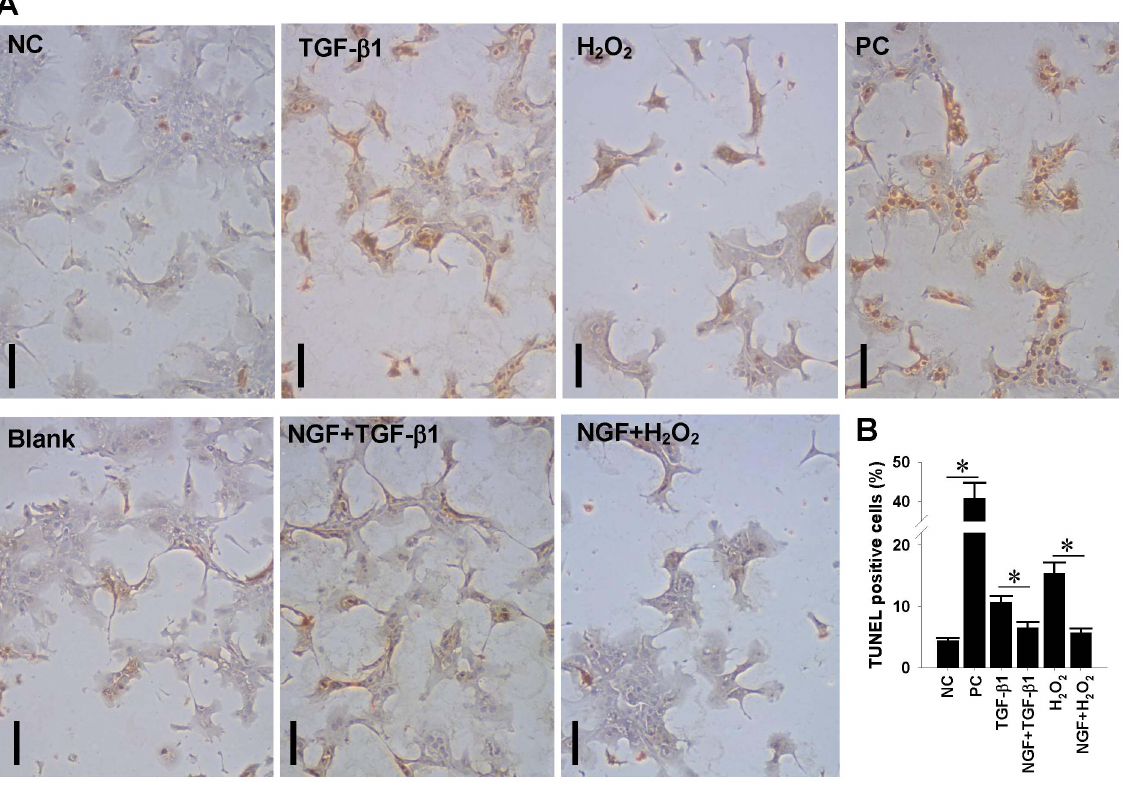
Figure 7. Anti-apoptotic effect of exogenous NGF pretreatment on TGF- b 1-induced and oxidative cell death of primary hepatocytes. Primary rat hepatocytes grown on collagen-coated chamber slides were treated with recombinant NGF at 20 ng/mL for 24 hrs and exposed to either TGF- b 1 at 50 ng/mL or H 2 O 2 at 500 m M for another 24 hrs. After treatments, cells were fixed with paraformaldehyde and subjected to in situ TUNEL staining for cellular apoptotic events. (A) Representative TUNEL staining images are shown (Bars =10 m m). Positive control (PC) was performed by treating cells with DNase I. (B) Nuclear TUNEL-positive signals were quantified by measuring 20 high-power fields per group and the positivity are shown in mean 6 SEM. * indicates P , 0.05 as compared with negative control (NC) or between